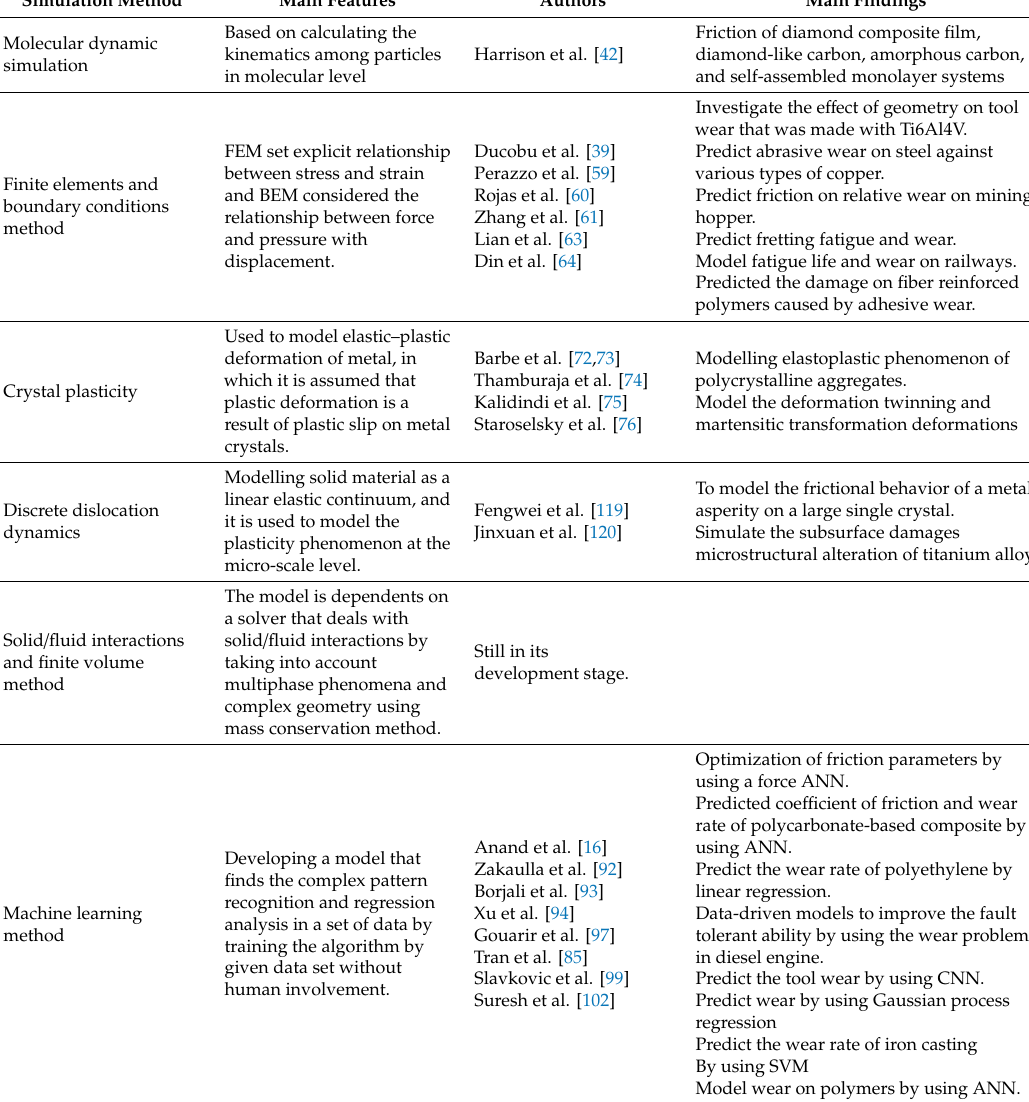
Table 1. Literature survey on simulation methods used to model and predict lubrication e ff ect on